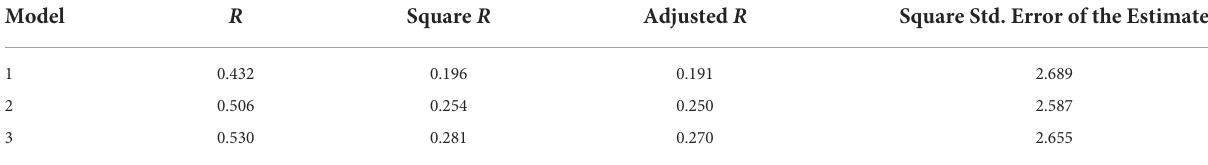
TABLE 5 Compound regression analysis of acceptance and